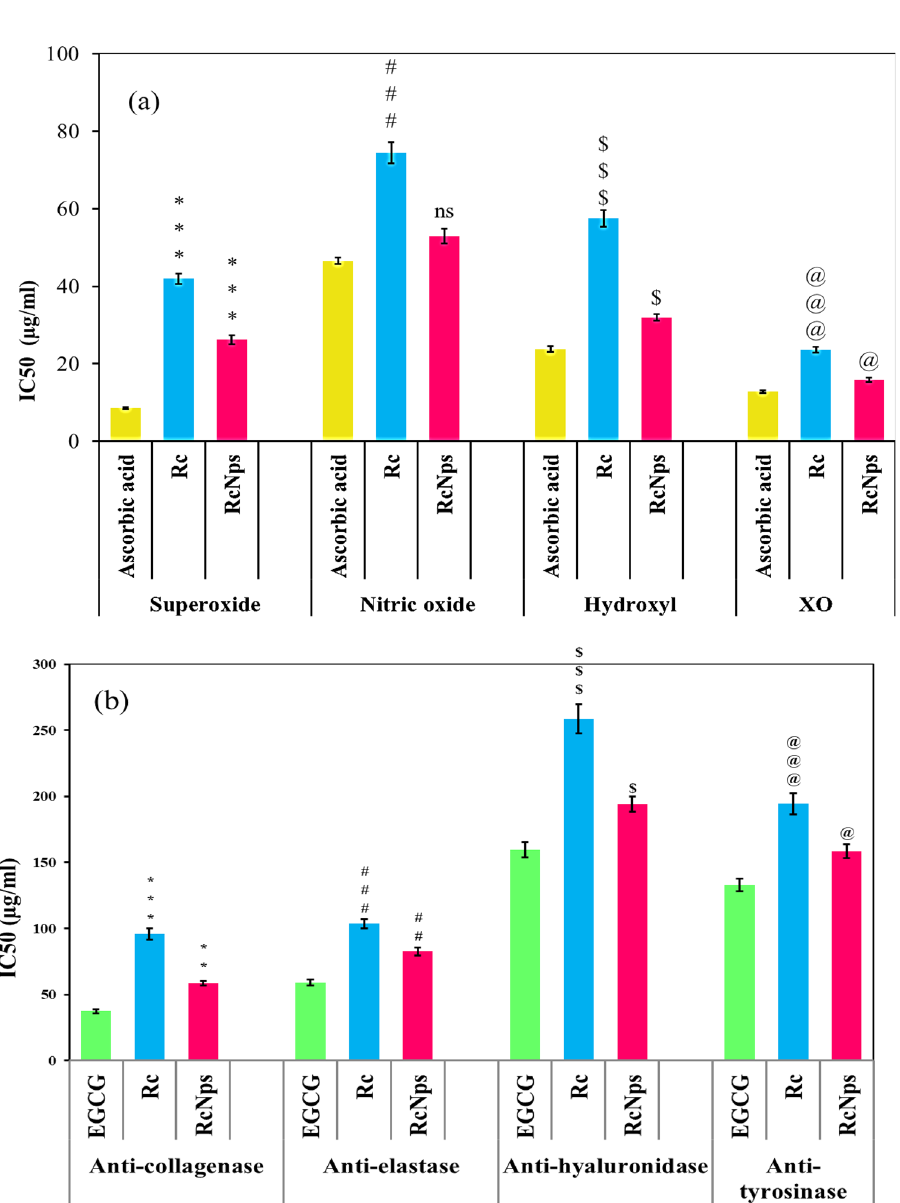
Figure 4. (a) Antiaging activity of the extract of Rosa (Rc) and its nano-form (RcNps) expressed as IC 50 in comparable to reference ascorbic acid. (b) Antiaging activity of the extract of Rosa (Rc) and its nano-form (RcNps) expressed as IC 50 in comparable to epigallocatechin-3-gallate(EGCG) .The data expressed as the mean of three parallel measurements (n = 3). One-way ANOVA followed by Dunnett’s multiple comparisons test statistically tested the differences between means. Significant difference from corresponding RA values was tested at @P < 0.05, **, ##P < 0.01 and ***, ###, $$$, @@@P <